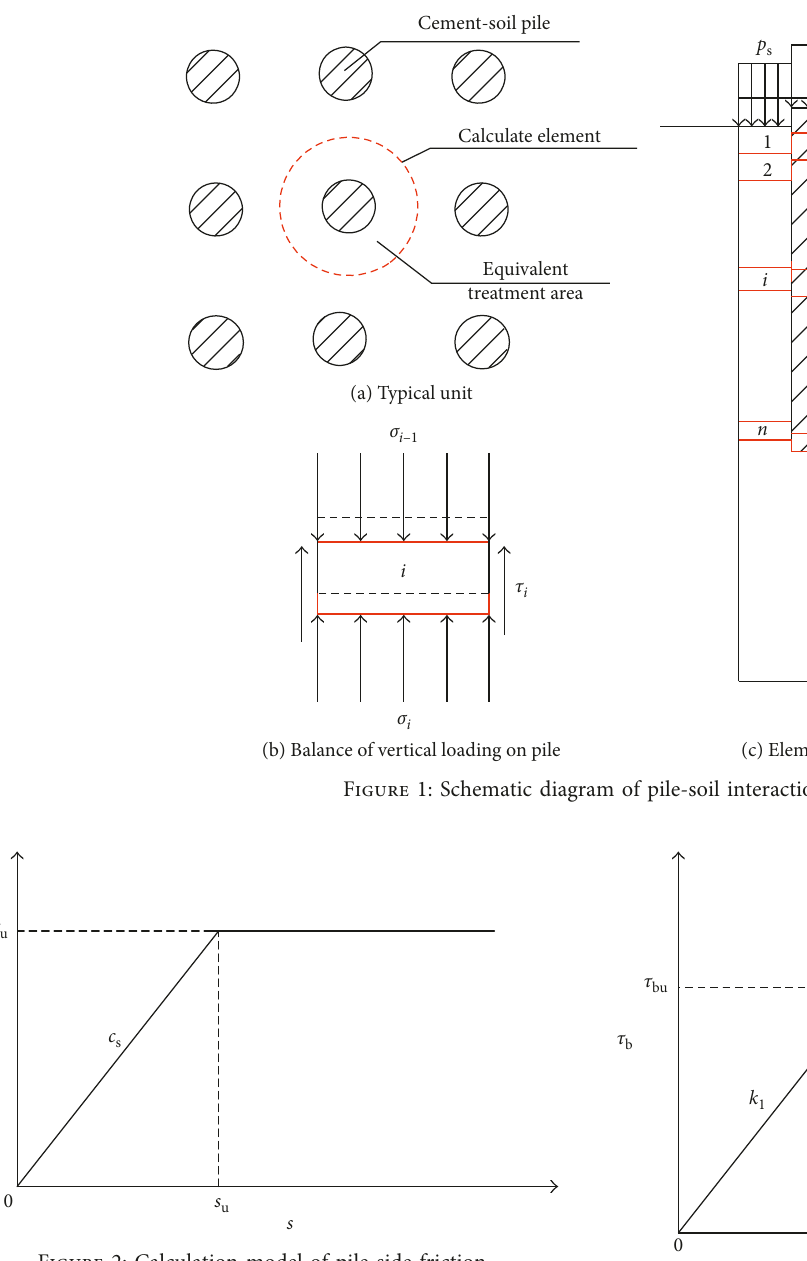
Figure 2: Calculation model of pile side friction.